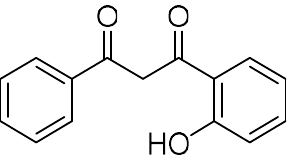
Figure 3. Base structure of synthetic flavonoid derivatives.